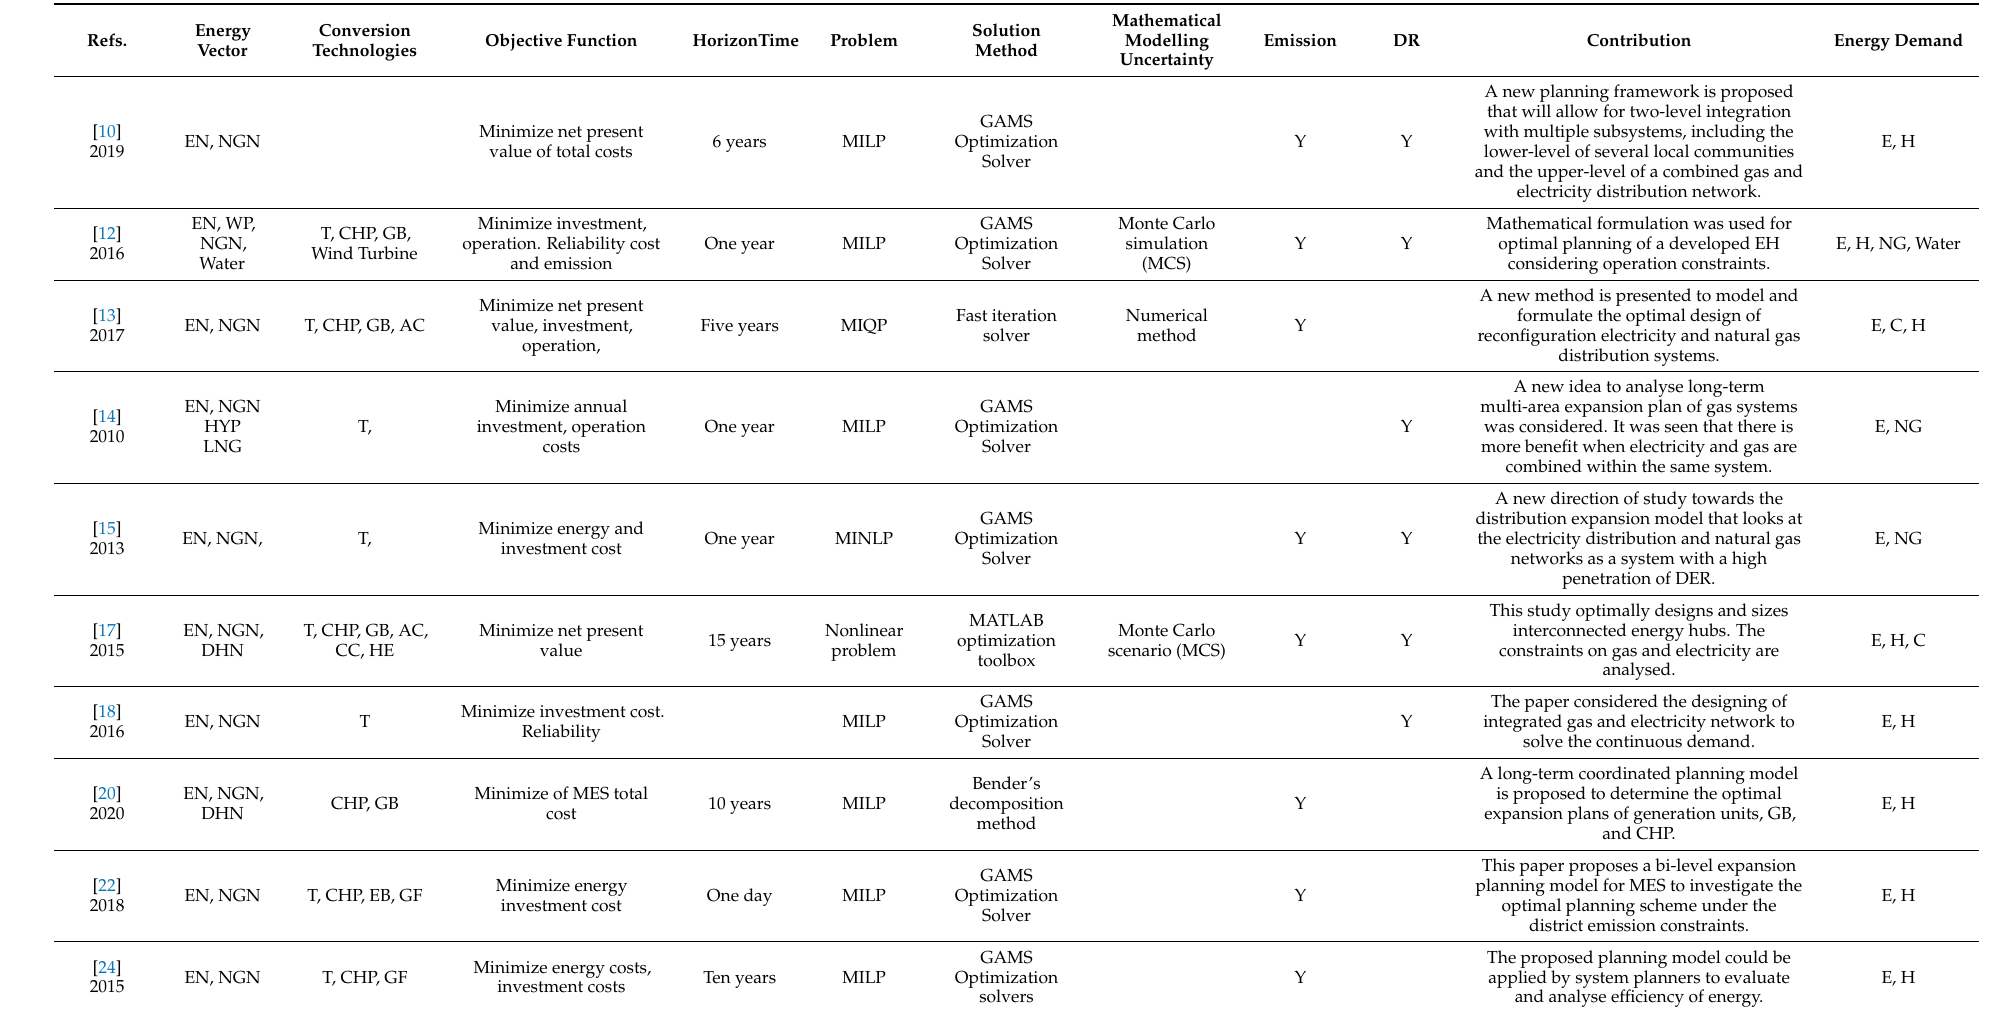
Table 1. A summary of recent works carried out on optimal planning of EH.